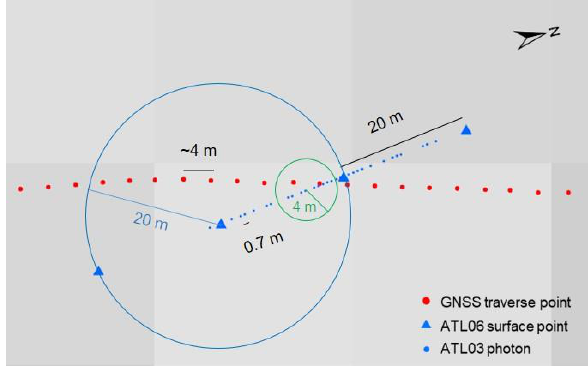
Figure 3. ATL06 ice surface points, ATL03 photons, and GNSS traverse points. 20 m is the searching radius (blue circle) for ATL06 points and 4 m is the searching radius (green circle) for ATL03